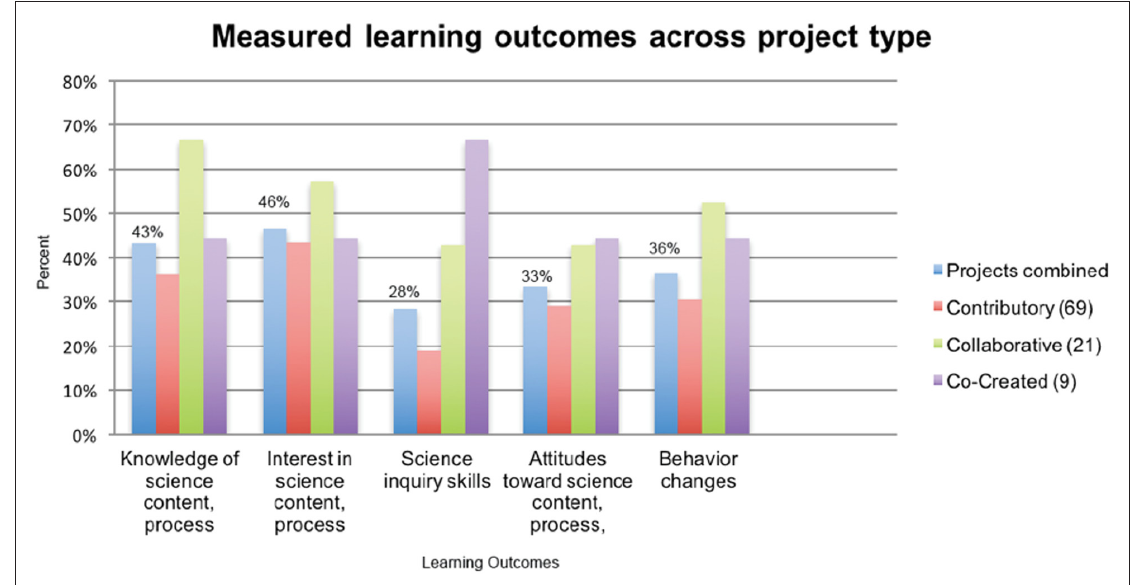
Figure 2: Measured learning outcomes from online survey of citizen science practitioners who reported having conducted some sort of evaluation (n =